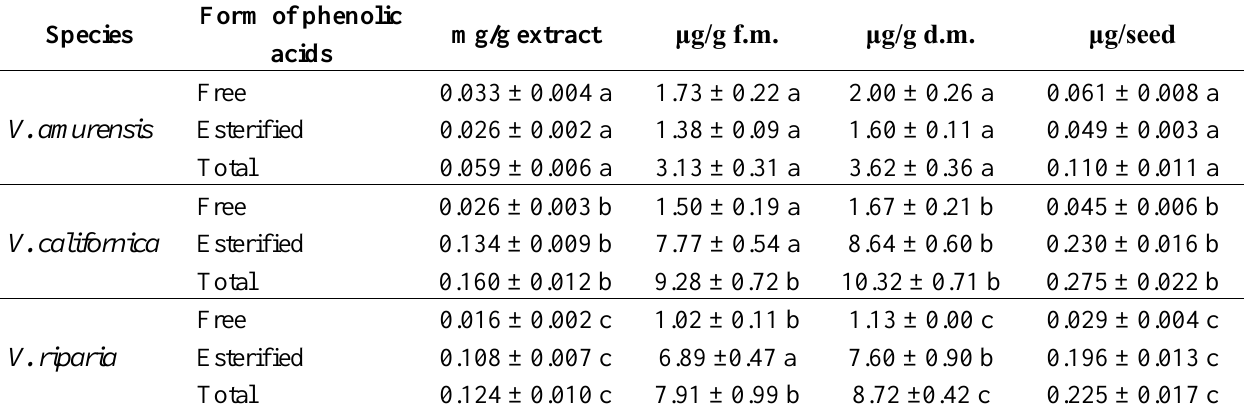
Table 5. Content of p -coumaric acid in the methanolic extracts and seeds.